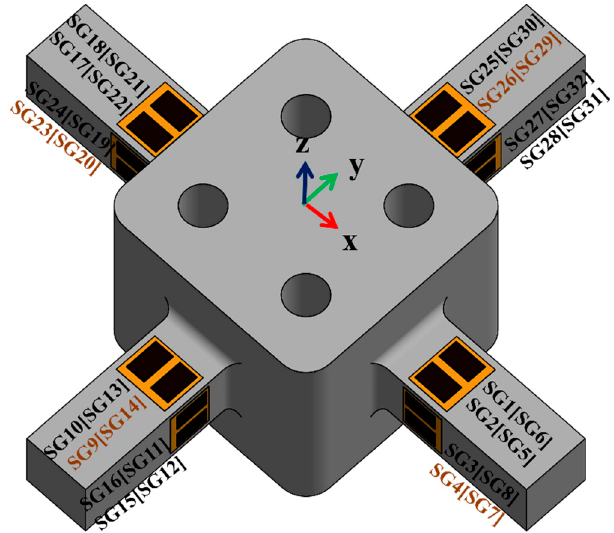
Figure 3. Configuration of strain gauges [23] .